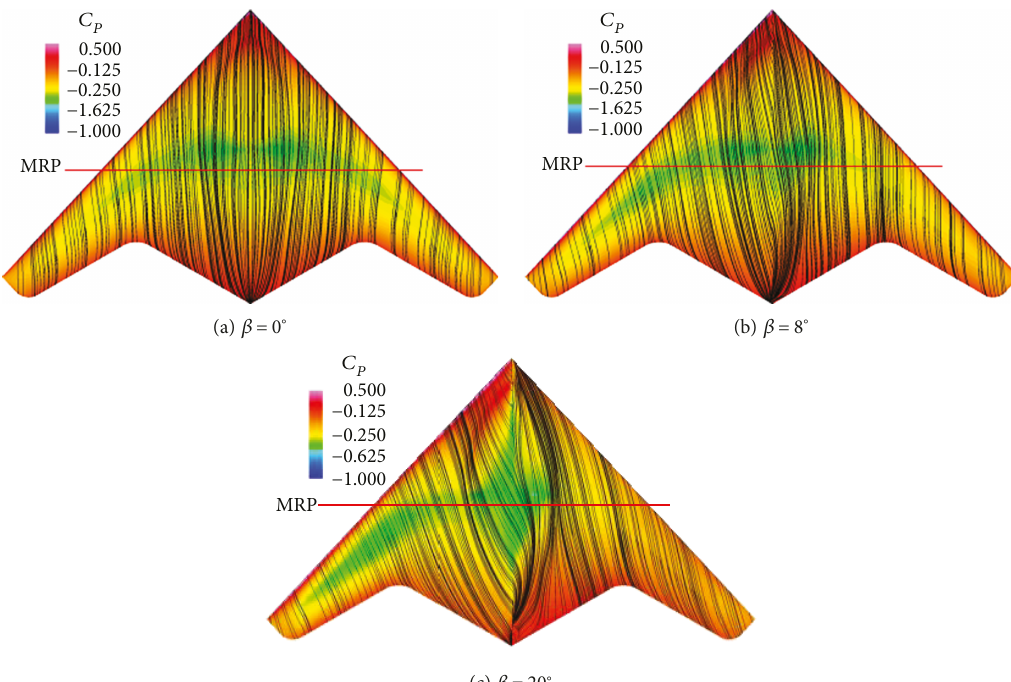
Figure 11: Skin friction lines and pressure coe ffi cient contours at angle of attack 0 °